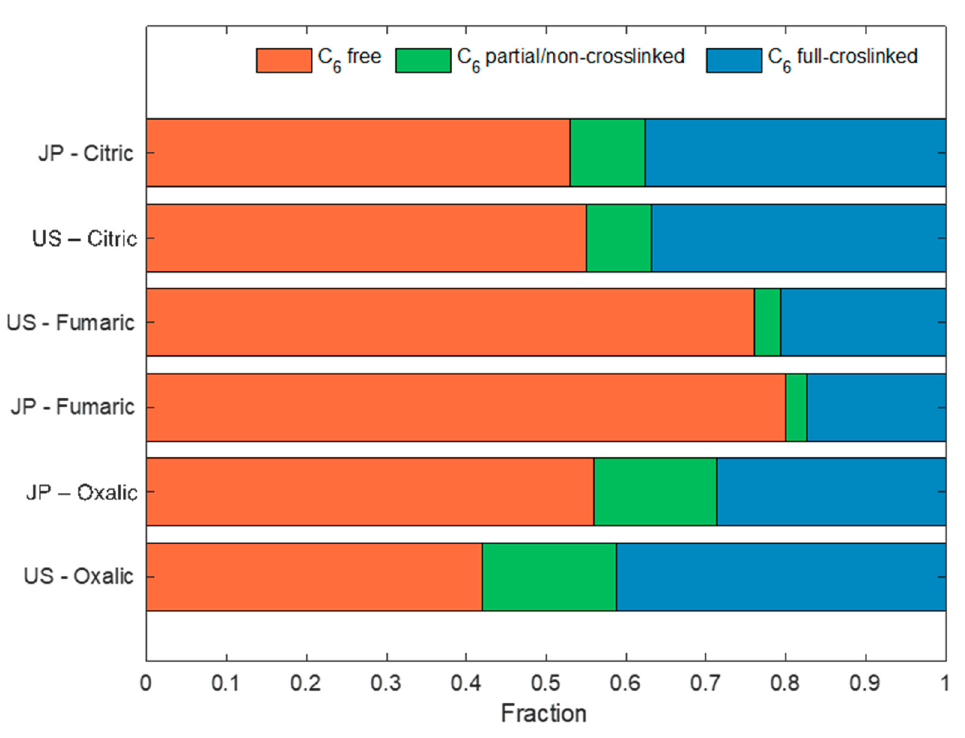
Figure 4. Distribution of C 6 reaction in different cotton types treated with different polycarboxylic acids under optimized conditions for each acid.